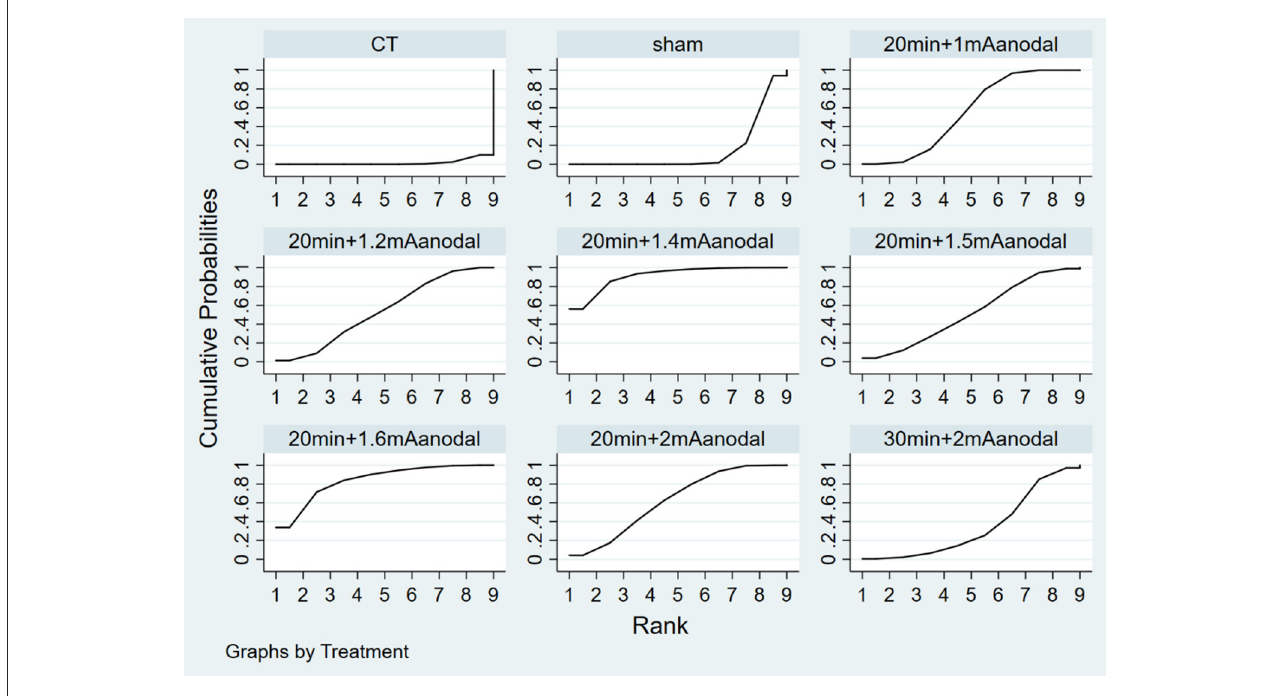
FIGURE6 SUCRA rank diagram.